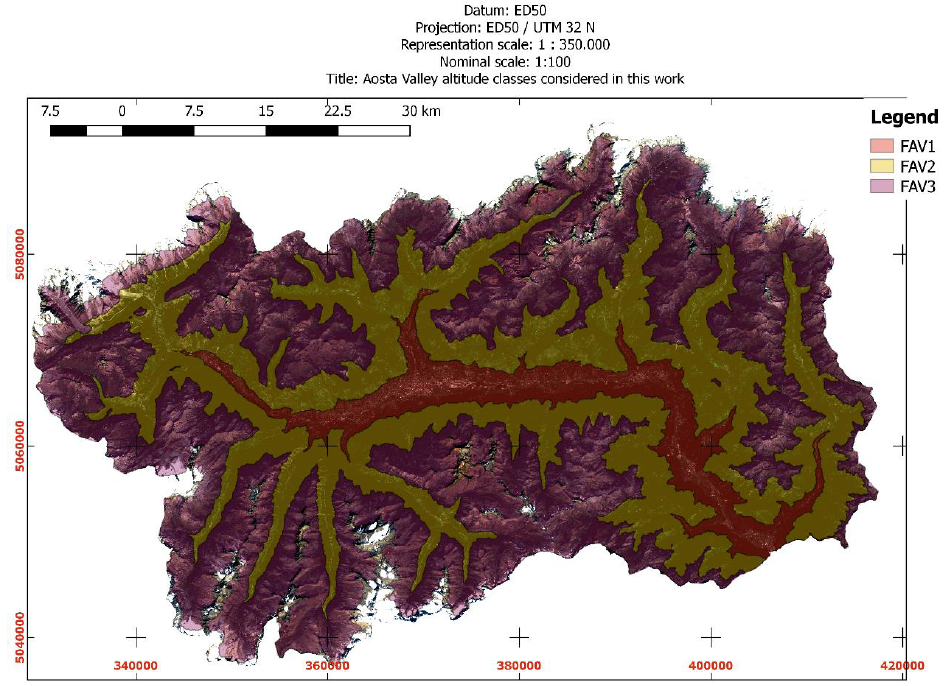
Figure 5. Aosta Valley altitude ranges: FAV1, FAV2, FAV3.